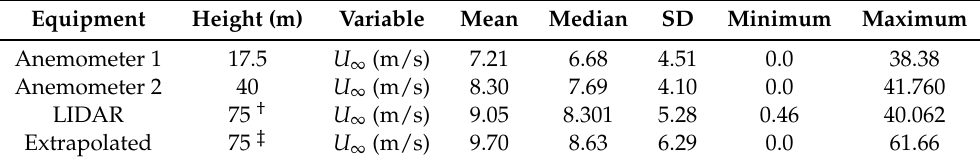
Table 1. Statistical measures of the two ultrasonic anemometers (1 Hz): LIDAR † (0.06 Hz) and extrapolated data ‡ (1